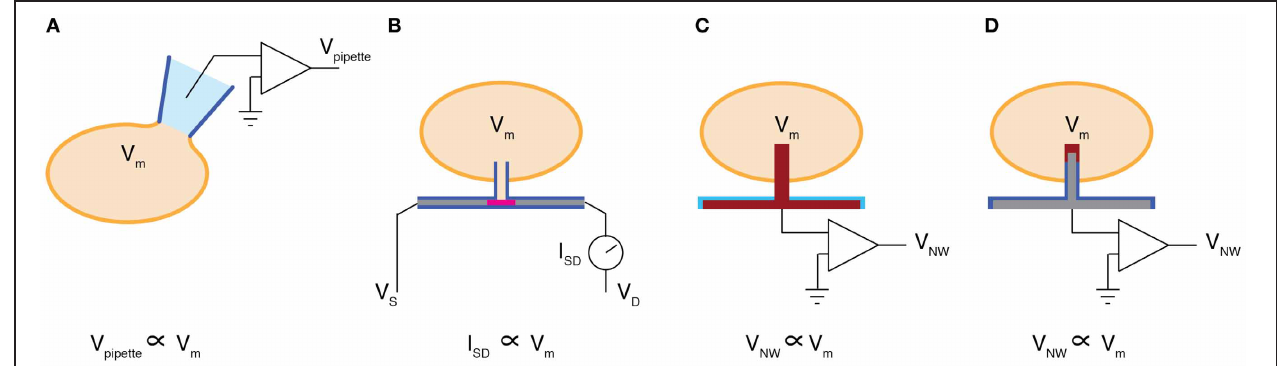
FIGURE 2 | Intracellular recording methods. (A) Whole cell patch pipette configuration measures a voltage (V pipette ) proportional to the membrane potential (V m ). (B) A vertical glass nanotube (blue) is grown on top of an FET (pink) that lies within an insulated NW (gray). When the nanotube penetrates the cellular membrane, the membrane potential can be measured as a change in the source-drain current (I SD ). (C) A platinum NW (red) is deposited on top of a platinum